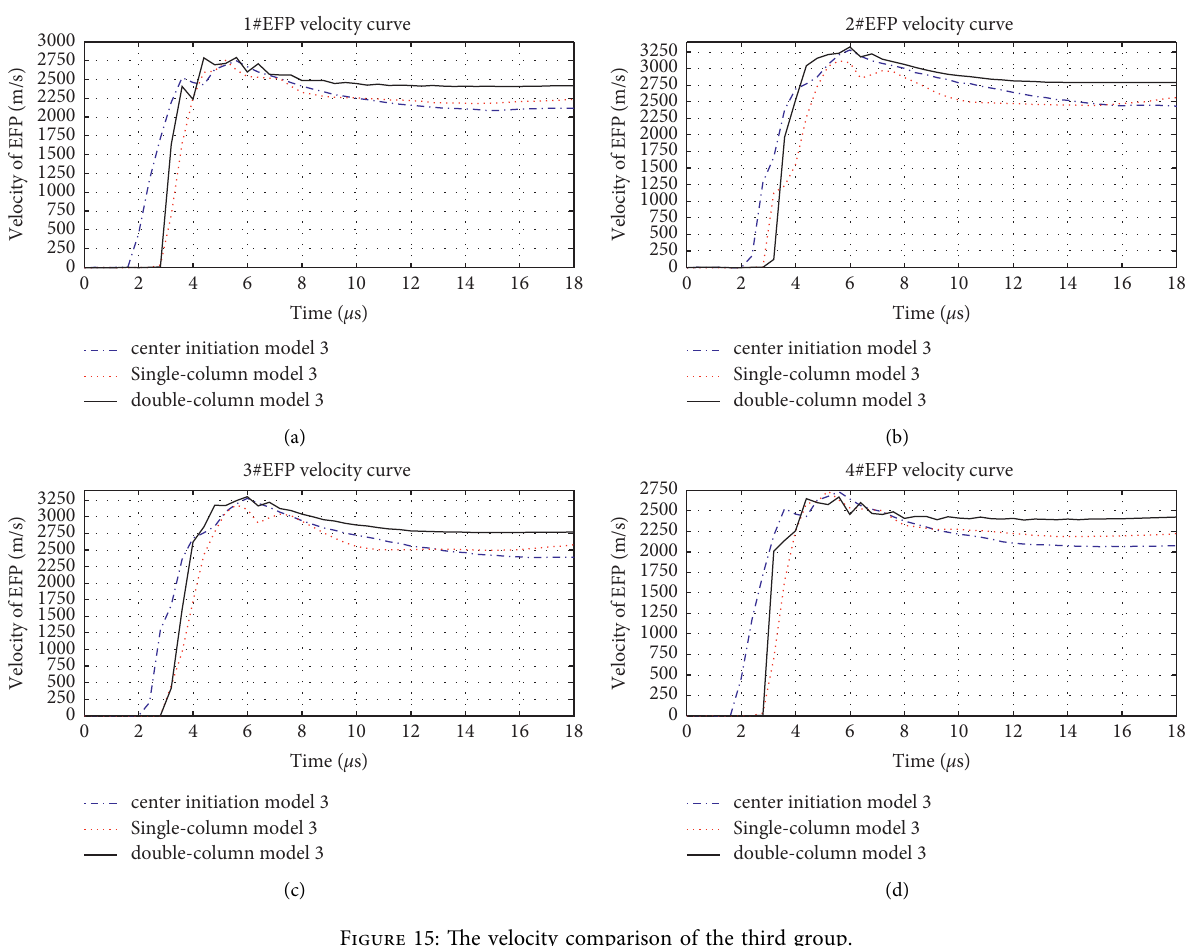
Figure 15: The velocity comparison of the third group.